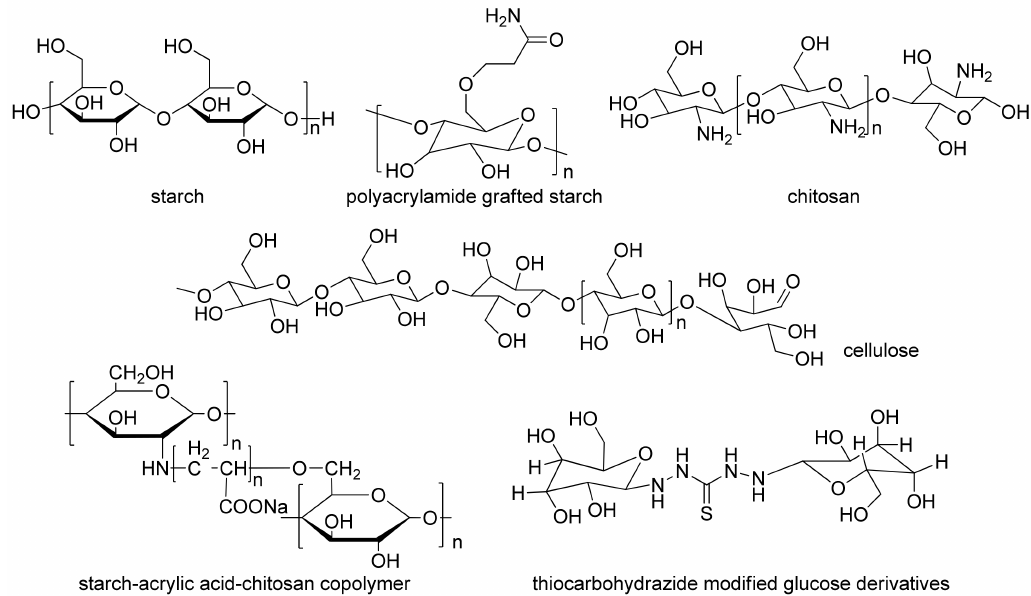
Figure 3. Typical chemical structures of natural polymers are used in the design of